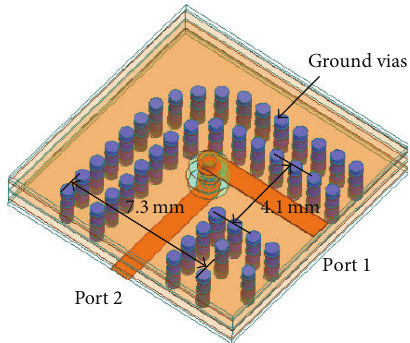
Figure 10: 3D view of the right angle MS-to-MS